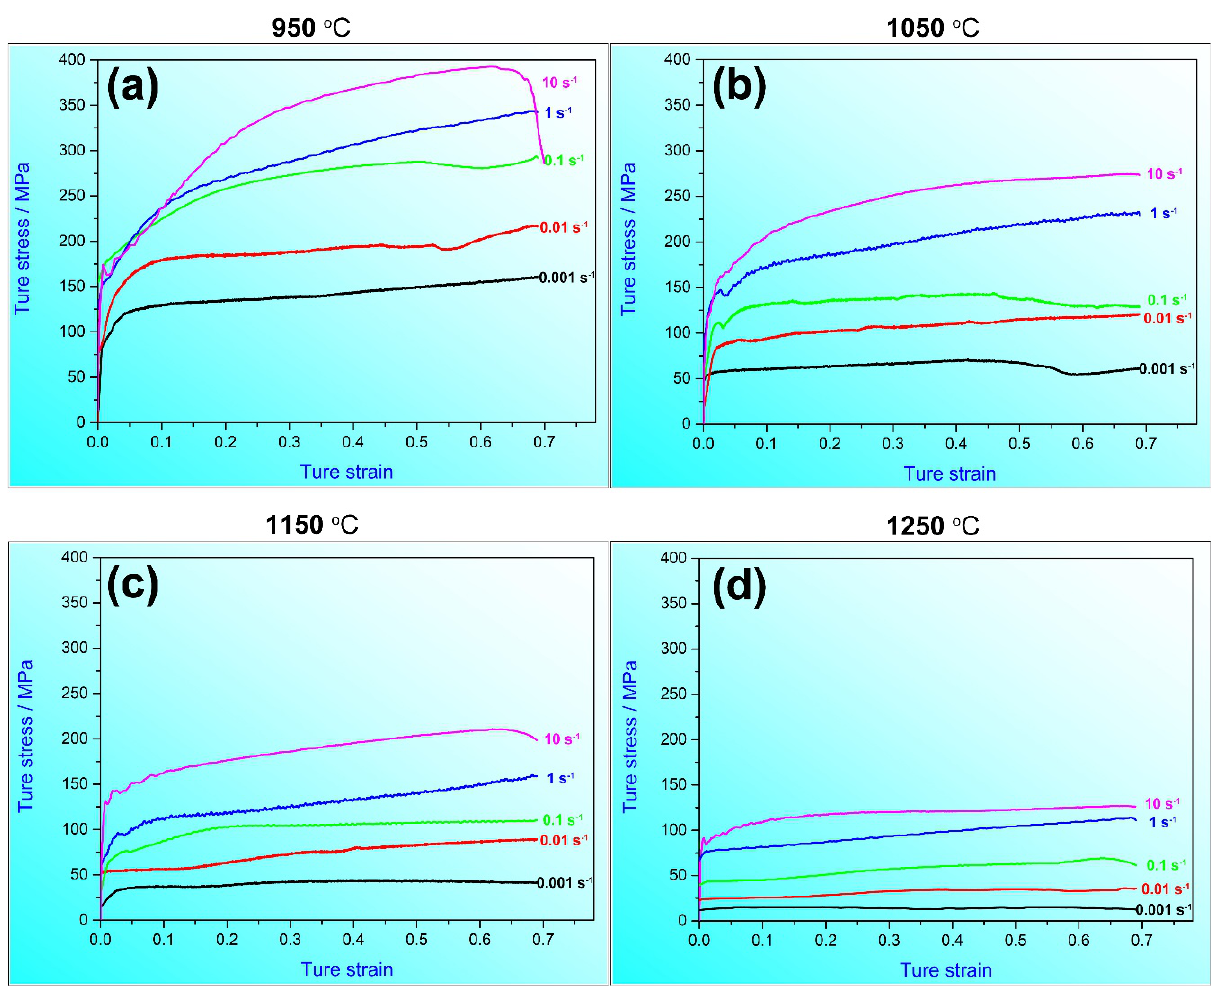
Figure 4. The true stress–strain curves of S31254 SASS specimens compressed at various temperatures of 950 °C ( a ), 1050 °C ( b ), 1150 °C ( c ), and 1250 °C ( d ).